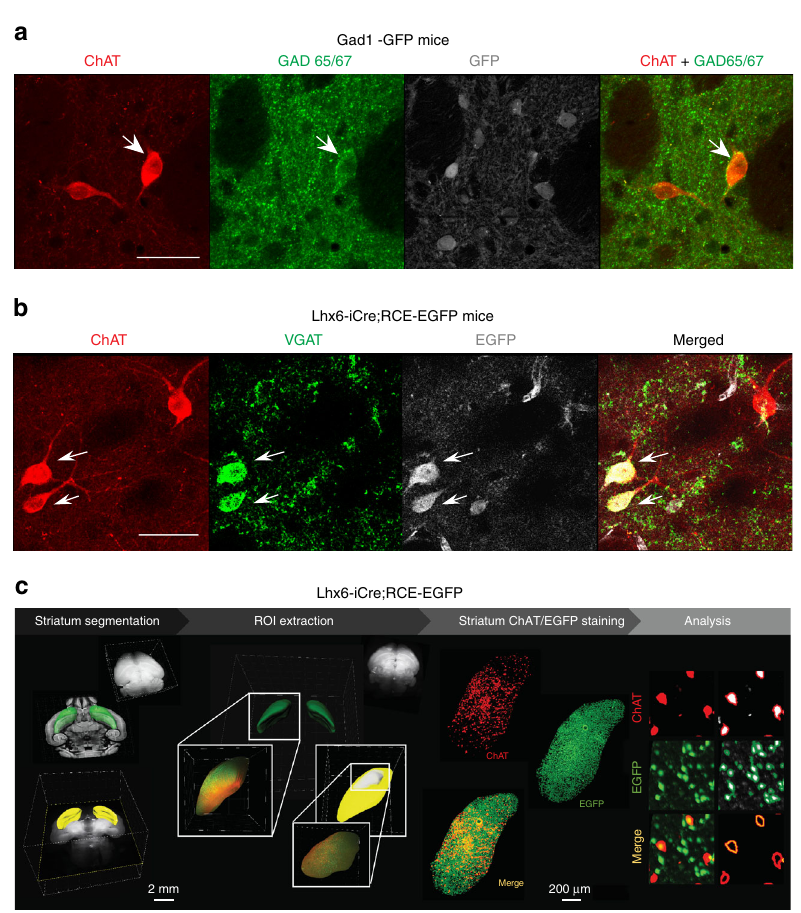
Fig. 2 Identi fi cation and quantitative assessment of CGIN/CIN ratio in dorsolateral striatum using immunocytochemistry and iDISCO clari fi cation techniques. a ChAT (red), GAD65/67 (green), and GAD1-GFP (gray) co-immunostaining of coronal striatal slices from GAD1-GFP mice showing expression of GAD65/67 in one of ChAT + cells (white arrow). Scale bar: 40 µ m. b ChAT (red), VGAT (green), and EGFP (gray) co-immunostaining of coronal striatal slices from Lhx6-iCre;RCE-EGFP mice showing co-expression of VGAT and EGFP in a subset of ChAT + cells. Scale bar: 40 µ m. See Supplementary Table 6 for statistics. c iDISCO experimental design: segmentation of the striatum, extraction of a region of interest (ROI, dorsolateral striatum) with IMARIS software. ChAT staining (red) in representative dorsolateral striatum from Lhx6-iCre;RCE-EGFP mice. Analysis, left column: immuno fl uorescence signal showing ChAT + and EGFP + Lhx6 cells; right column: cell pro fi ler analysis with automatic cell detection (white) and cells co-immunopositive for ChAT and EGFP Lhx6 (orange) (see Supplementary Table 7 for statistics and Supplementary Movie